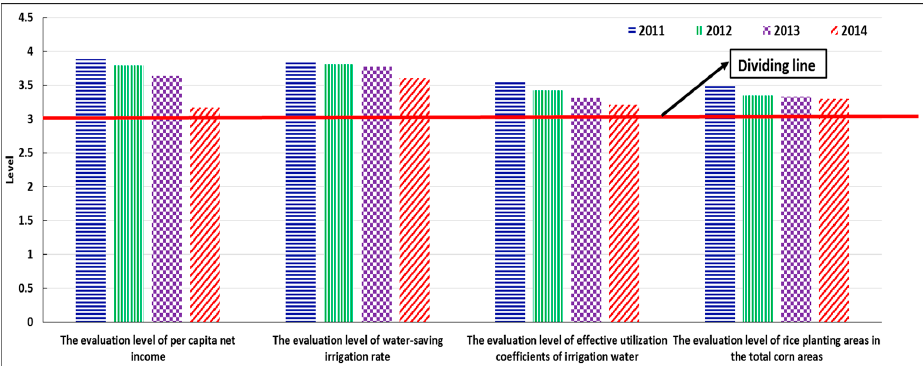
Figure 5. Agricultural water usage efficiency control level in terms of its efficiency indicator parameters in Jiangxi Province during 2011–2014.